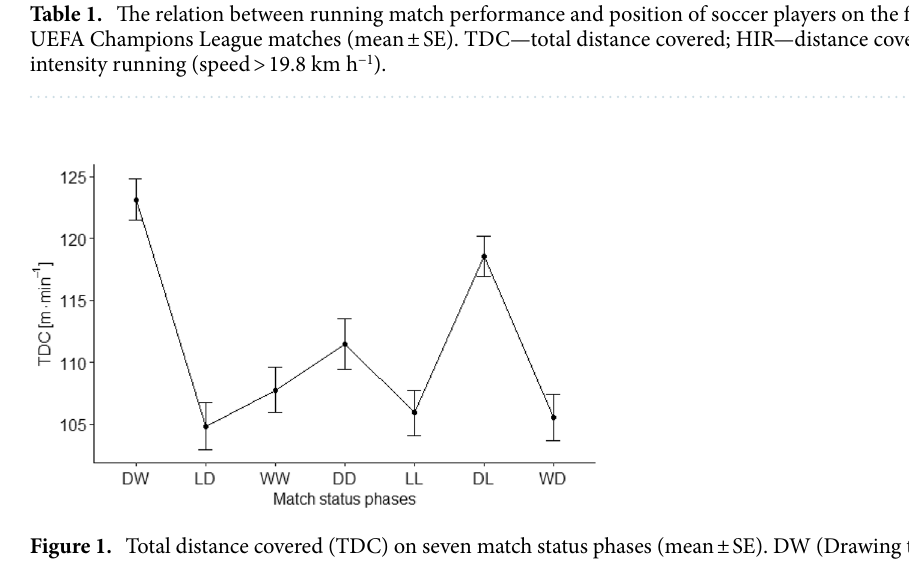
Figure 1. Total distance covered (TDC) on seven match status phases (mean ± SE). DW (Drawing to Winning); LD (Losing to Drawing); WW (Winning to Winning); DD (Drawing to Drawing); LL (Losing to Losing); DL (Drawing to Losing); WD (Winning to